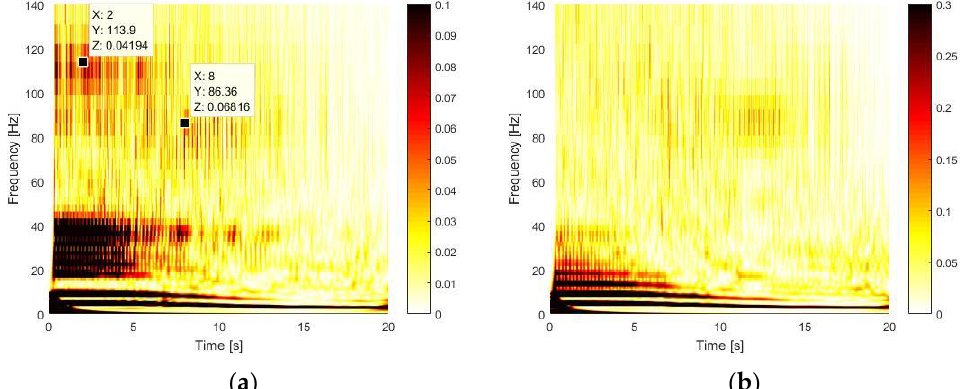
Figure 15. Time – frequency contents of CD test using CWT method for P11 (contact) ( a ) and P14 (mass) ( b ) profilometer points.